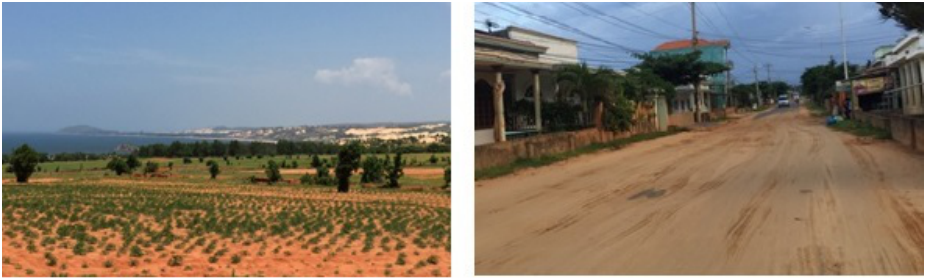
Figure 5. Cassava field in Binh Thanh commune ( left ); and sand-covered road near the coast in Lien Huong commune ( right